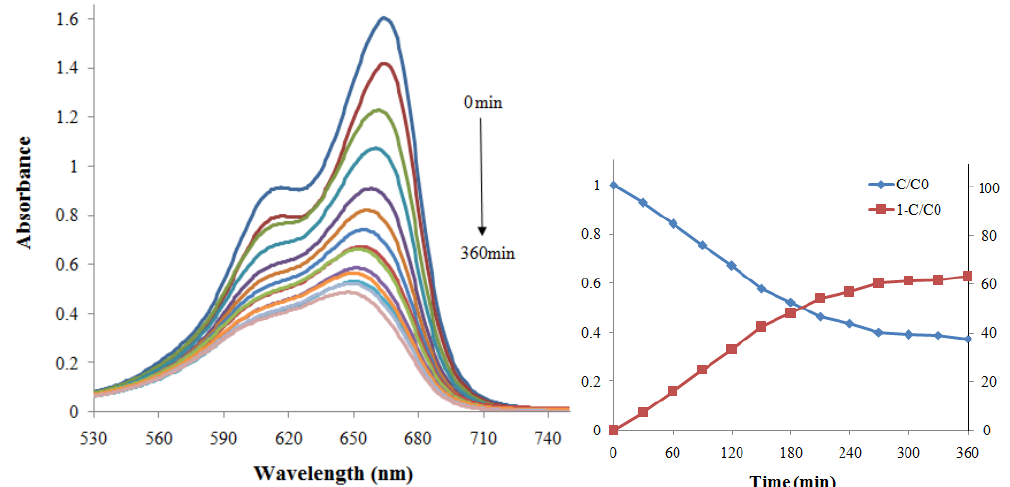
Figure 8. Absorption spectral changes and photodegradation of MB aqueous solution degraded by CdS nanoparticles under visible light.